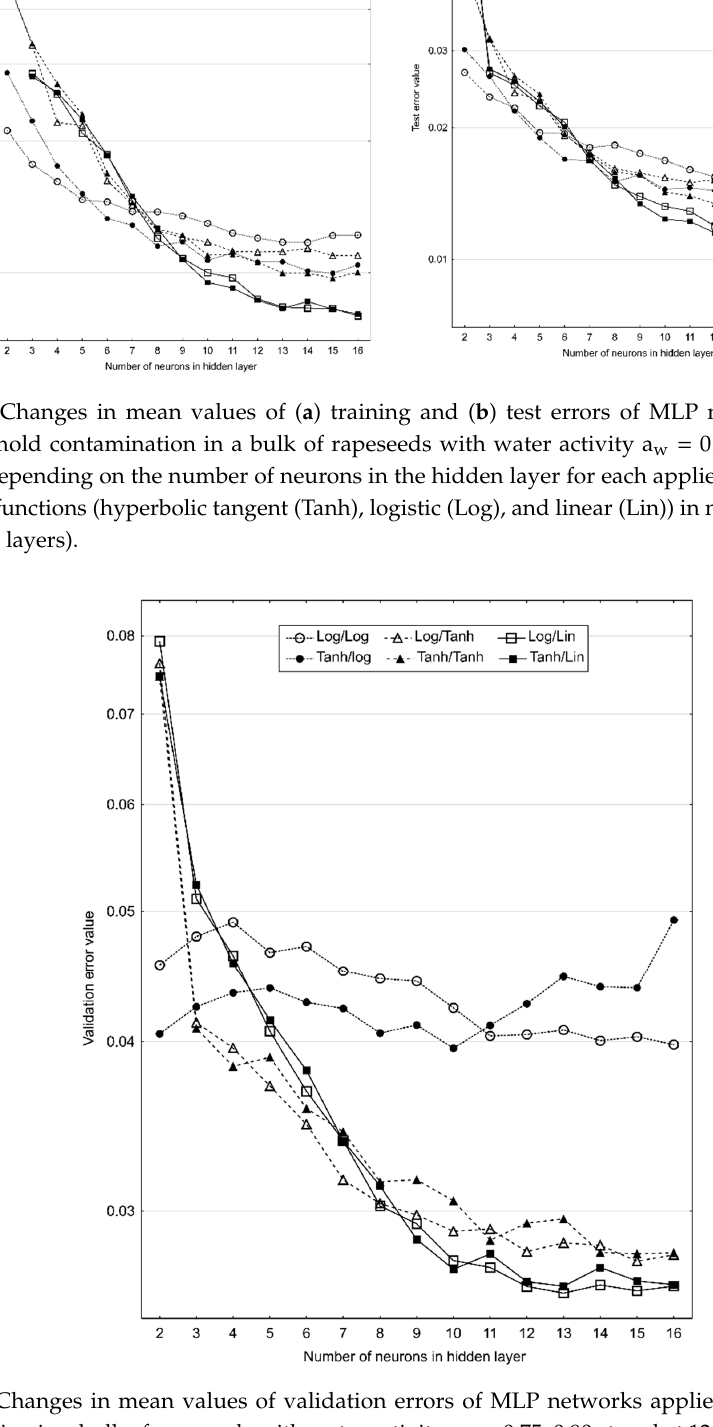
Figure 3. Changes in mean values of validation errors of MLP networks applied to model mold contamination in a bulk of rapeseeds with water activity a w = 0.75–0.90 stored at 12–30 °C depending on the number of neurons in the hidden layer for each applied combination of activation functions (hyperbolic tangent (Tanh), logistic (Log), and linear (Lin)) in neurons of the hidden and output layers).